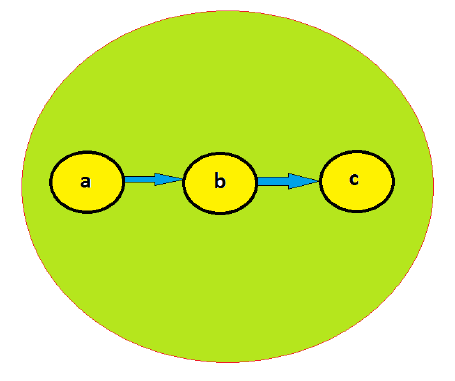
Figure 3. Radio Transmission Range of node b.